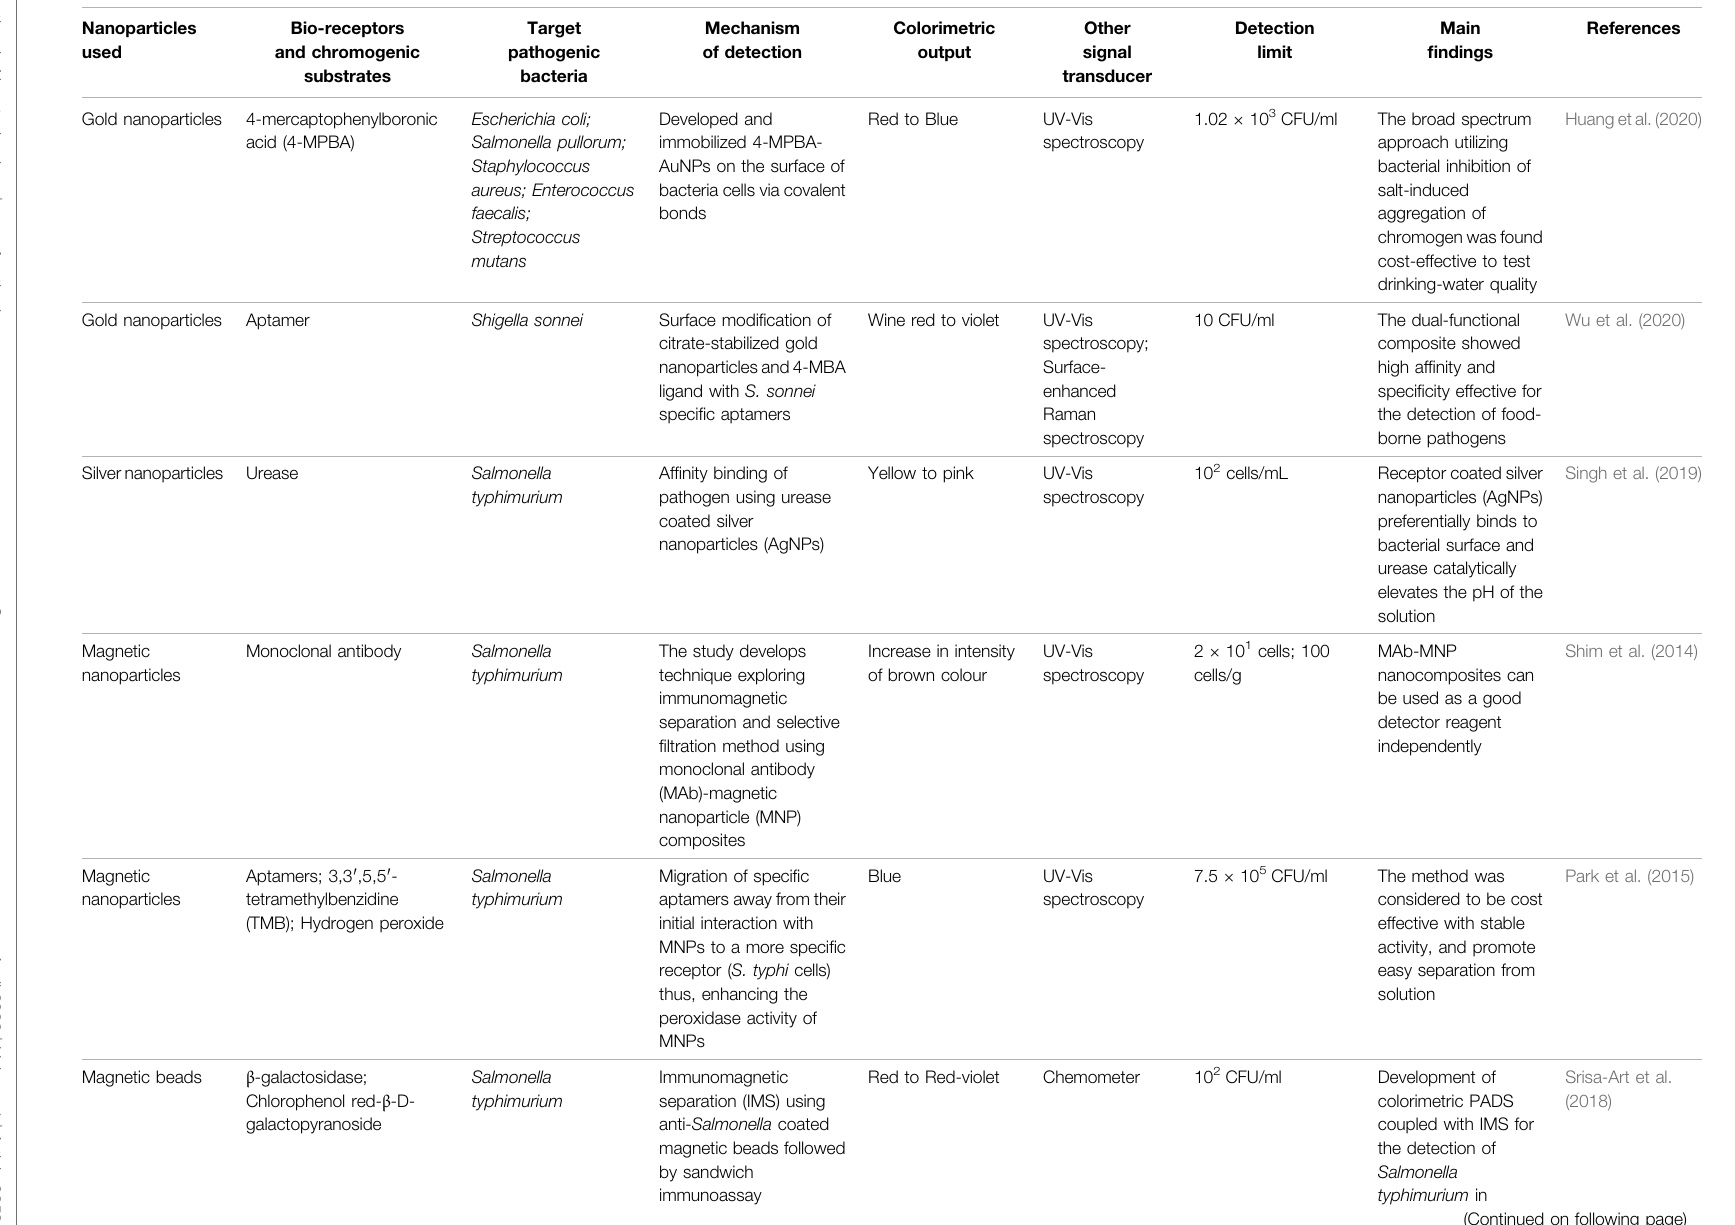
TABLE 2 | ( Continued ) Summary of studies that have applied bio-receptors and chromogenic substrates for the detection of pathogenic